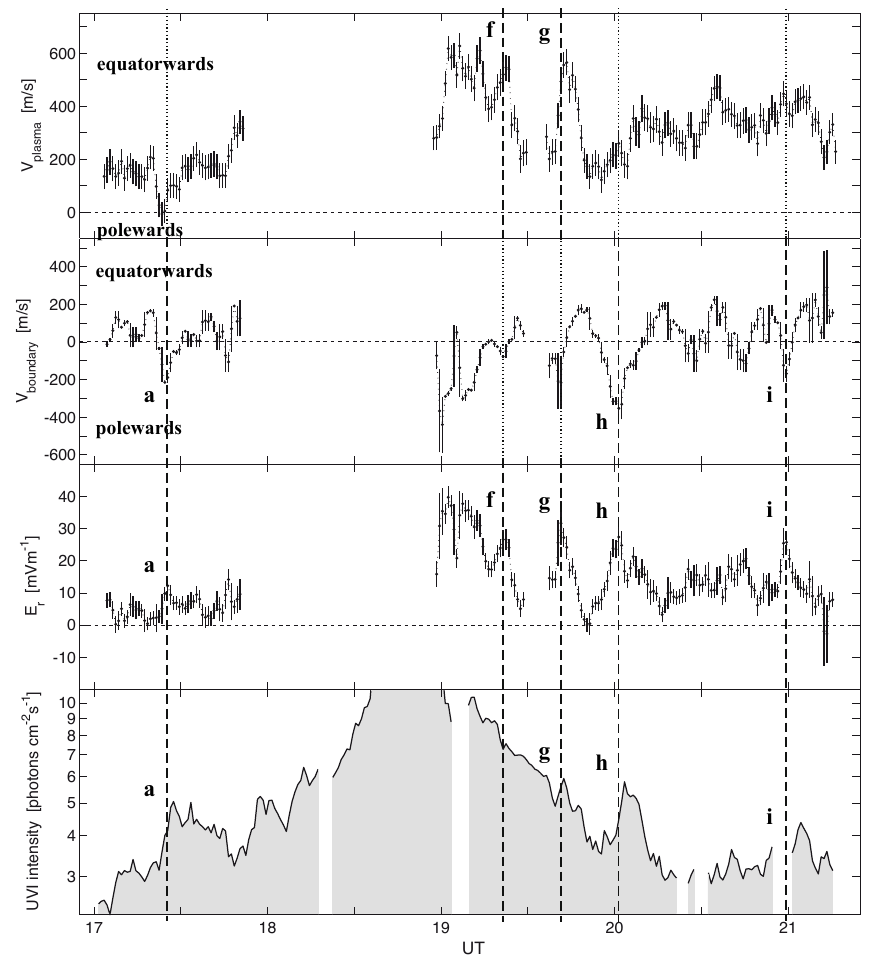
Fig. 9. Plasma drift velocity along the PCB normal, positive equatorwards (top panel). PCB velocity along the PCB normal, positive equatorwards (2nd panel). Ionospheric reconnection electric field, positive values indicate magnetic flux closure in the magnetotail (3rd panel). Vertical dotted lines show the maxima of the E r associated with auroral PBIs. The corresponding UVI frames in Fig. 9 are shown by a letter. Weighted average UV intensity (bottom